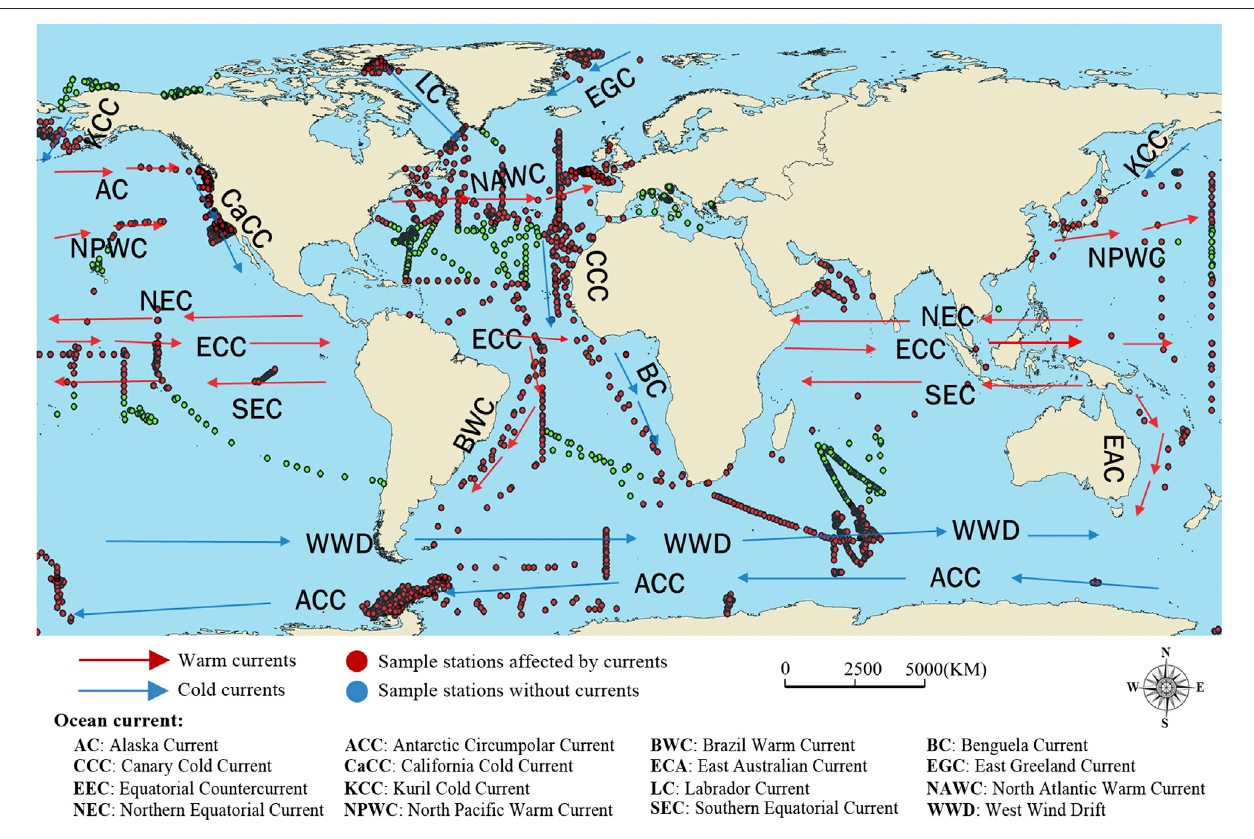
FIGURE 1 | Geographical locations of sample stations used in our study and ocean currents ’ sketch map.